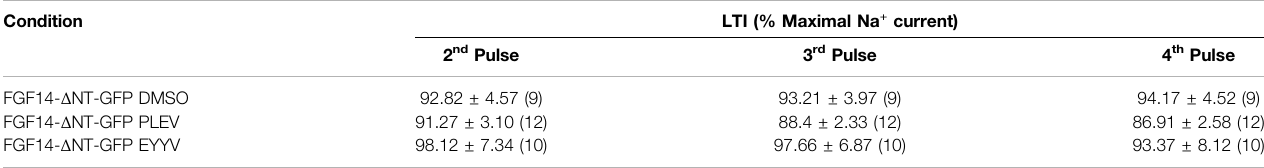
Data are mean ± SEM; ns (cid:2) nonsigni fi